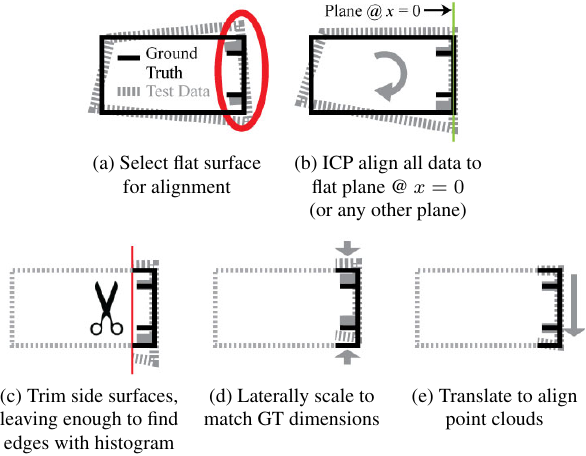
Figure 7. General overview of local flat plane